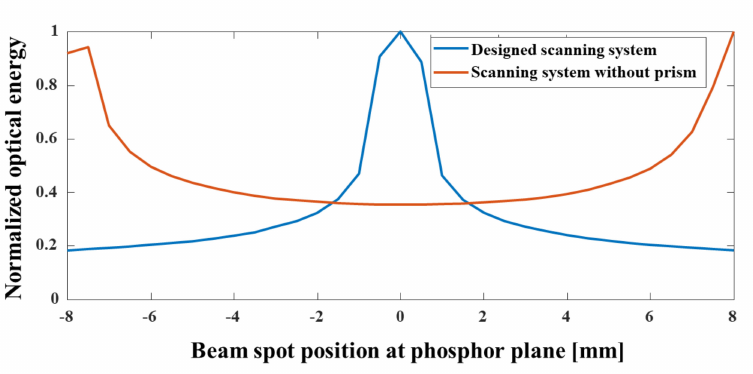
Figure 11. Normalized optical energy measured in designed scanning system with prism and scanning system without prism according to beam spot position at phosphor plane.